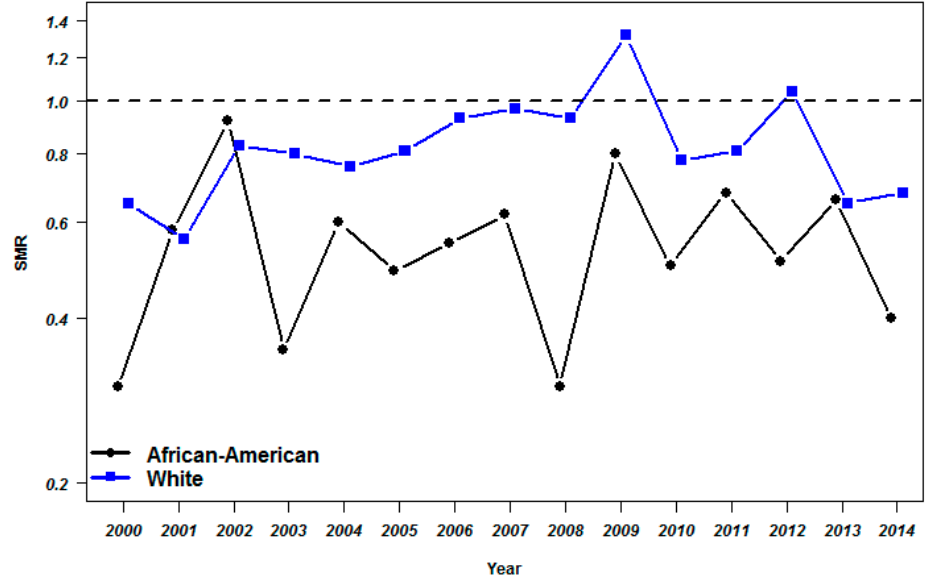
Figure 3. Standard mortality ratios between observed and expected mortality rates among African- American and white NBA players, compared to their respective general US populations.